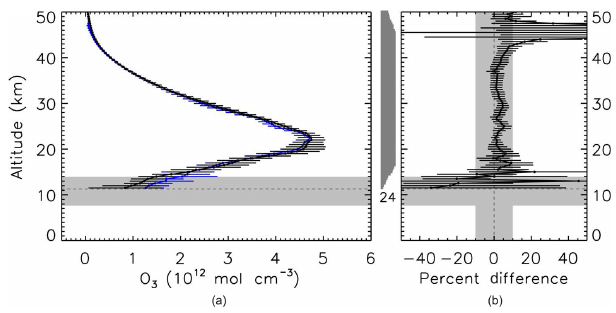
Figure 2. (a) The average of all coincident pairs for SAGE III- ISS data and Hohenpeißenberg ozone lidar data from June 2017 to May 2018. The average SAGE III-ISS ozone profile is shown using the black line with twice the standard error ( ± 2SEM) dis- played as the black error bars. The average Hohenpeißenberg lidar ozone profile is shown using a blue line with twice the standard er- ror shown as horizontal blue error bars. (b) The average percentage difference between the coincident pairs is also shown. The black line indicates the percentage difference, the black horizontal error bars show twice the standard error of the difference, and the vertical gray shading shows the ± 10% region. The horizontal gray shading shows the altitude range of the tropopause for panels (a) and (b) . The horizontal light gray dotted line shows the average altitude of the tropopause height as reported in the SAGE III-ISS data product. The vertical shading on the left of panel (b) indicates the variation in the number of coincident measurements at each altitude (24 in total).